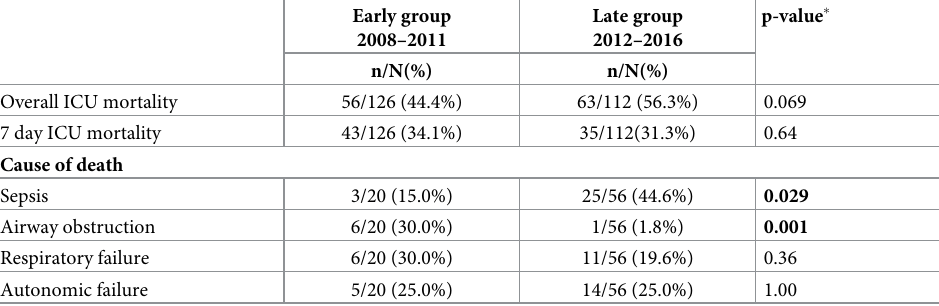
Table 3. Overall ICU mortality, 7-day mortality and causes of death in the early and the late groups.